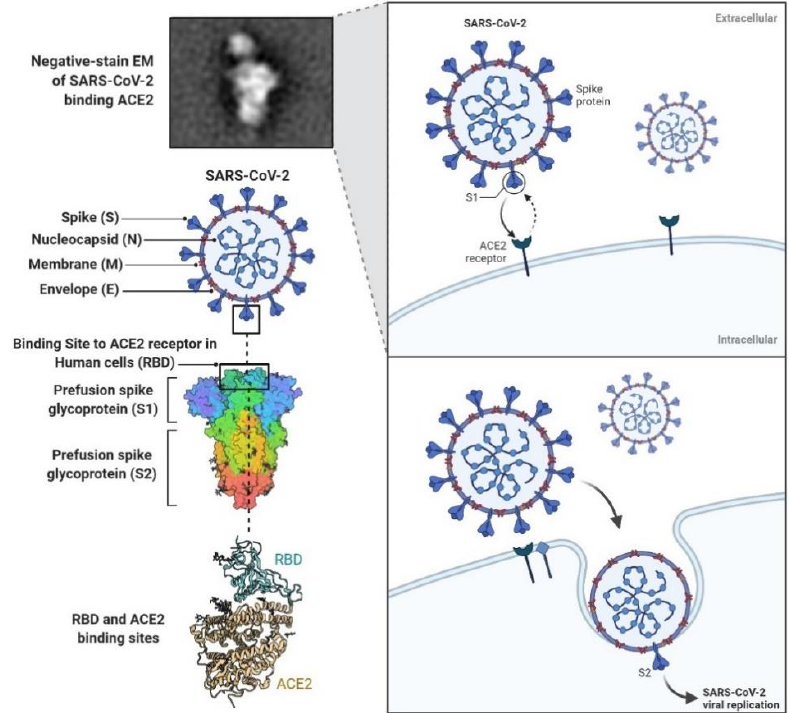
Figure 1. Schematic representation of the structure of important SARS-CoV-2 proteins, targeting the ACE2 receptors and promoting viral entry in infected cells. The SARS-CoV-2 spike (S) protein mediates membrane fusion by binding to these cellular receptors (retrieved from https://app.biorender.com/biorender-templates (access date: 06 March 2021)): “SARS-CoV-2 Targeting of ACE2 Receptor and Entry in Infected Cell” ).